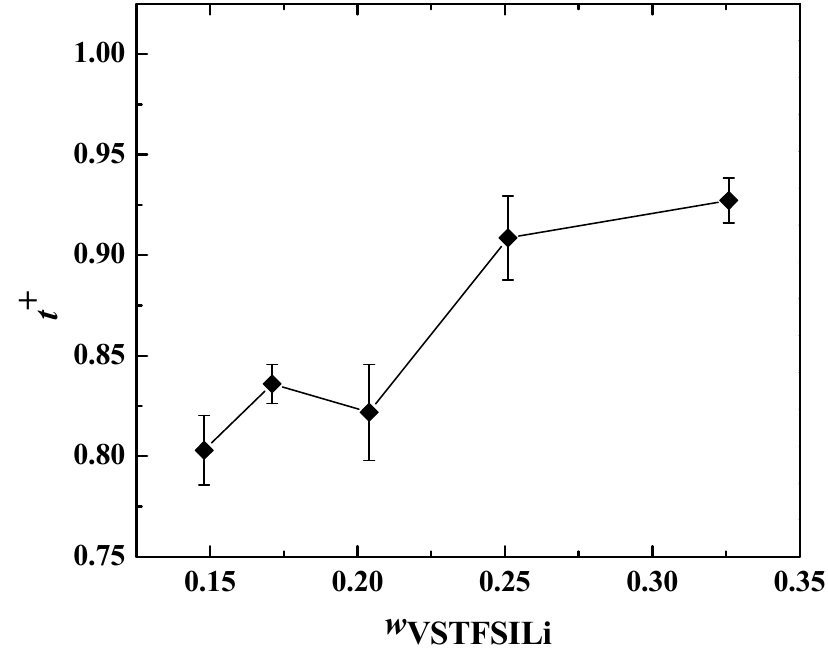
◦ C as a function of w VSTFSILi . The lines are guidelines